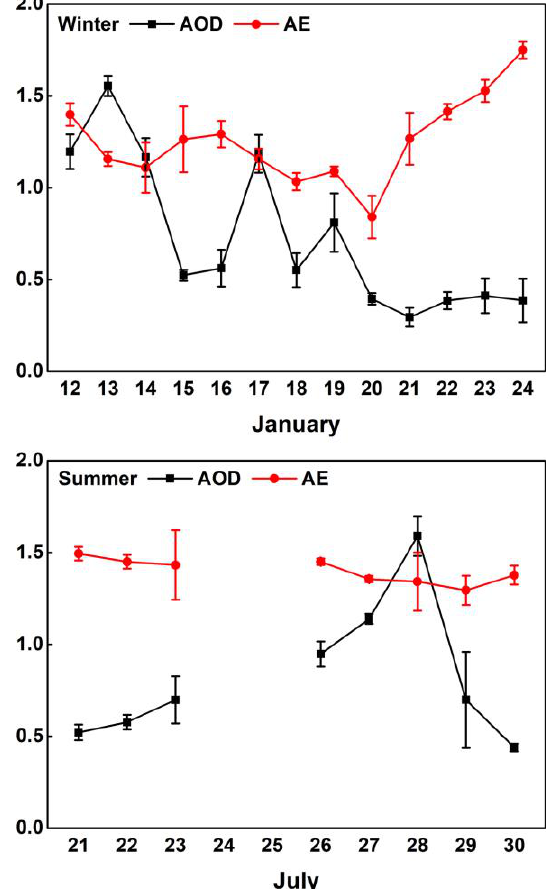
Fig. 1 Time series chart of AOD (500 nm) and AE (440-870 nm) in January (winter) and July (summer). 3.1.2 Aerosol size distribution: The ASD is depicted in Fig. 2, showing a bimodal size distribution dependent on integrative action of fine and coarse mode particles during the clear air and haze periods. The peak of fine mode particle changed from 0.034 μm 3 /μm 2 to 0.068 μm 3 /μm 2 in winter and it varied from